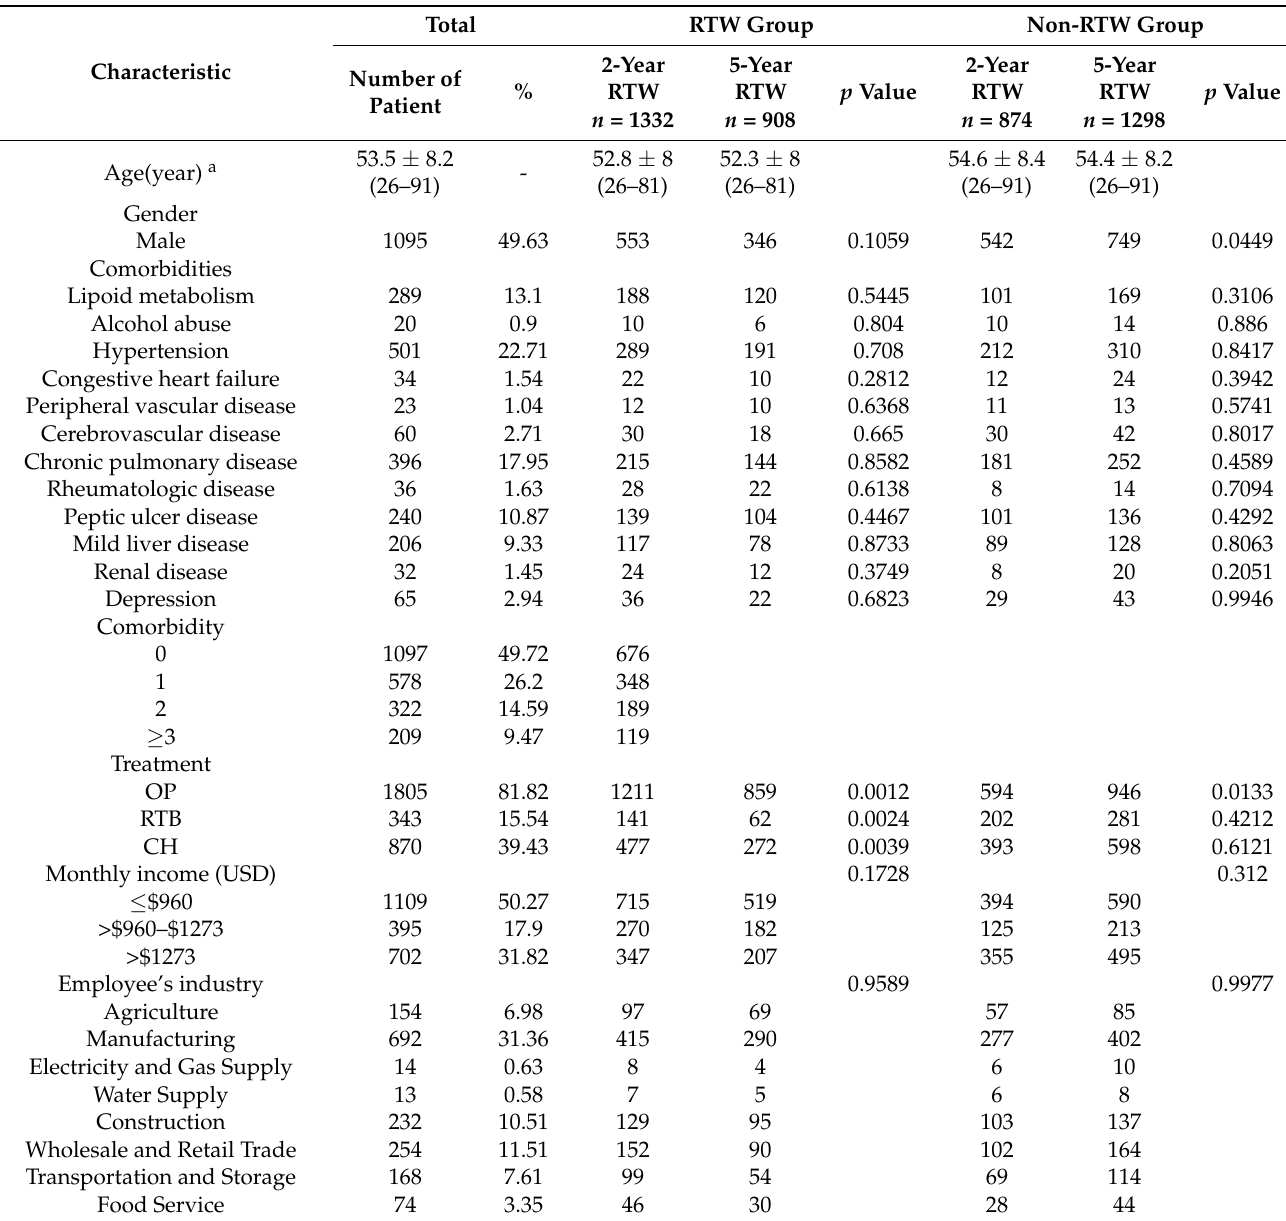
Table 1. Characteristics of the study